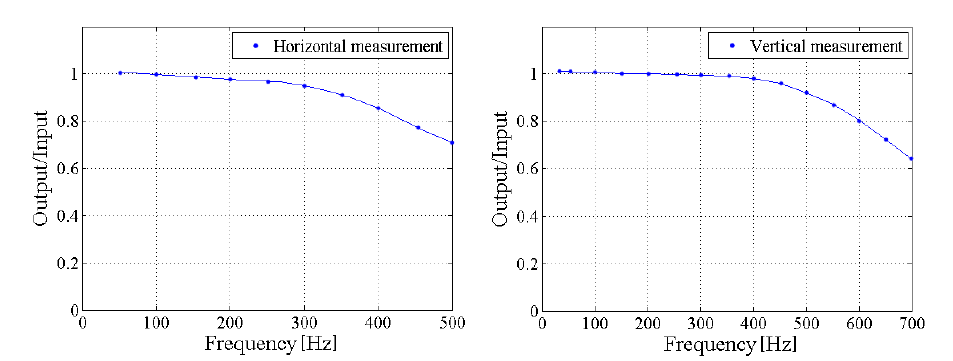
Figure 10. Amplitude frequency characteristic